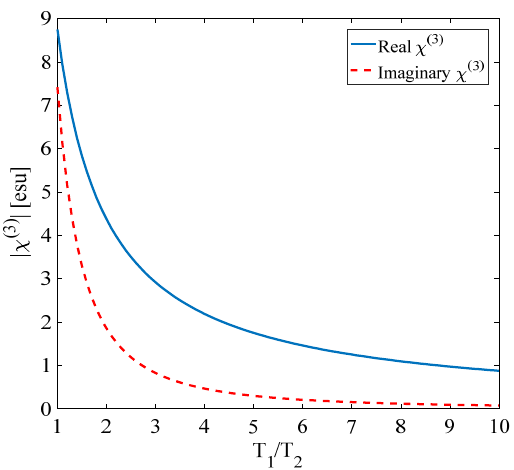
Figure 6. Third-order nonlinear optical susceptibility vs. population loss factor T 1 / T 2 in the laser annealed ZnO nanostructures.